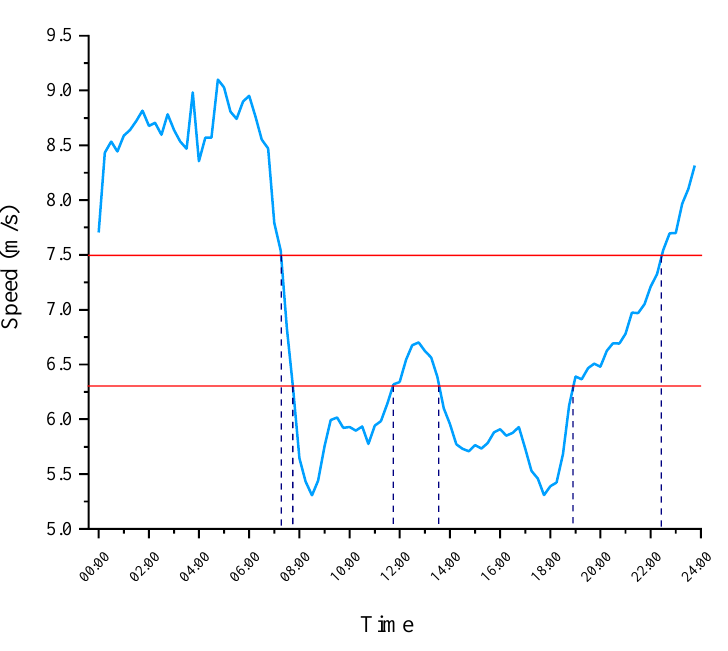
Figure 5. Time division based on speed.